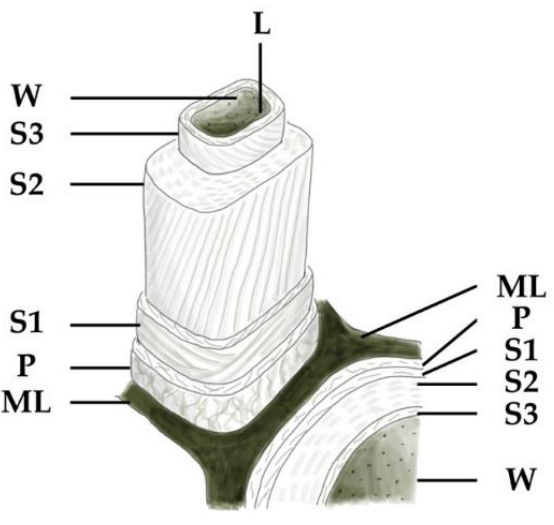
Figure 1. Model of a wood cell. Drawing by S. Svorová Pawełkowicz . The aim of this paper is to study interactions between planar titanium dioxide particles and wood matter. The paper focuses on describing the phenomena occurring as the UV energy is absorbed by a TiO 2 layer built from amorphous, so, by definition, non-photocatalytic TiO 2 particles. The key issue is whether this energy can affect the morphology and molecular composition of wood’s surface. For the study, beech wood (a representative of broadleaved trees) and pine wood (a representative of conifer trees) were chosen, as both are easily degradable by UV light [32]. Beech and pine sapwood are woods most commonly used for degradation tests because of their low resistance to biological decay (see standards EN 113 [33], EN 839 [34], and EN 252 [35]). Furthermore, pine sapwood is recommended in standards EN 927-3 [36] and EN 927-6 [37] for testing the durability of coating materials and coating systems for exterior constructions. Wood specimens have been coated with planar particles of TiO 2 mixed with water, acrylic resin, and water glass. The use of binders complicated the system but at the same time made the study more realistic as, in the long run, nanoparticles will not stick to a wood surface exposed to external conditions with van der Waals forces only. The choice of acrylic resin was dictated by its popularity and nontoxicity, and its mechanical properties (elasticity) [26]. Nevertheless, an additional reaction between organic acrylic matrix and TiO 2 was expected, as reported in the literature [6,26,38]. That is why we looked for an inorganic matrix, such as water glass. Wood specimens were submitted to artificial aging simulating environmental conditions. The absorbance of UV radiation of TiO 2 particles was measured by UV-VIS spectroscopy. X-ray fluorescence (XRF) mapping was helpful in locating the proper place for extracting samples for further measurement from the wood specimens. Irradiated and reference wood specimens were inspected with transmission electron microscopy (TEM) to describe changes in the wood’s ultrastructure, and with Fourier transform infrared spectroscopy (FTIR) to describe the chemical changes triggered by the interaction of TiO 2 and UV light. The efficiency of TiO 2 coating has been proved, albeit to a limited extent. Fissures in the wood matter of beech wood were observed around clusters of TiO 2